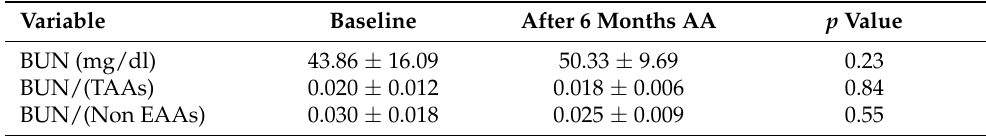
Table 9. Blood Urea Nitrogen (BUN), BUN / Total Amino Acids (TAAs) BUN/non Essential AA (non EAAs) ratio in CKD patients at baseline and after 6 months of AA supplementation. Variable Baseline After 6 Months